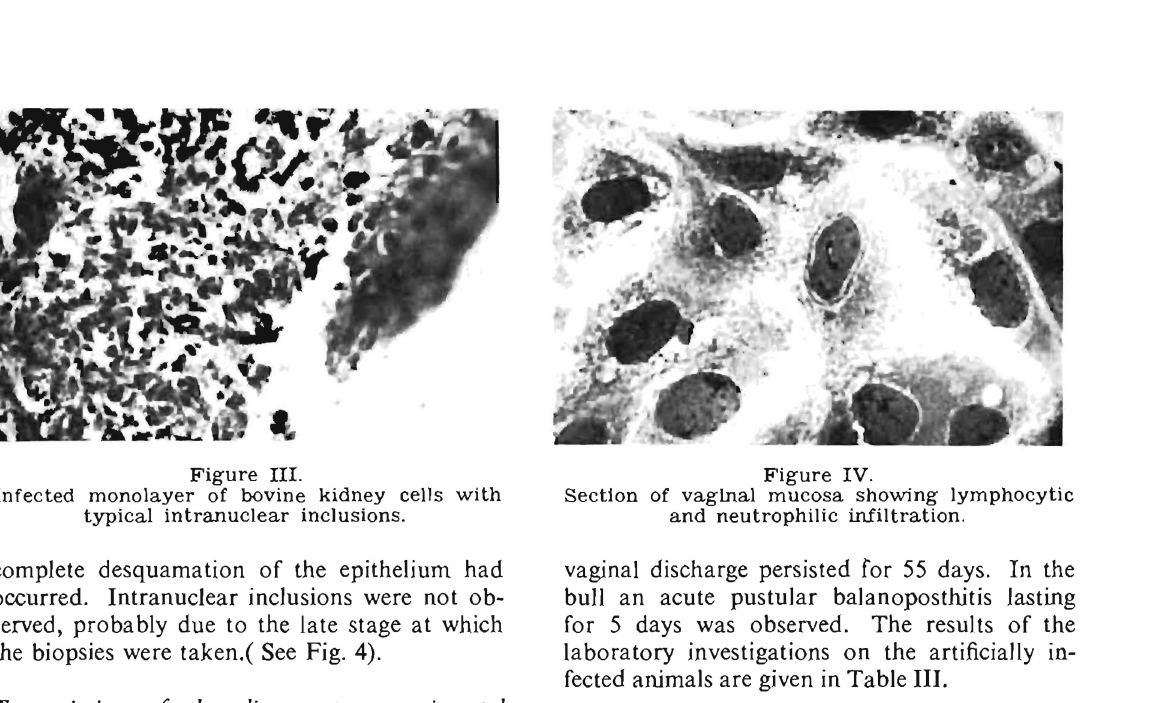
Figure III. Infected monolayer of bovine kidney cells with typical intranuclear inclusions.